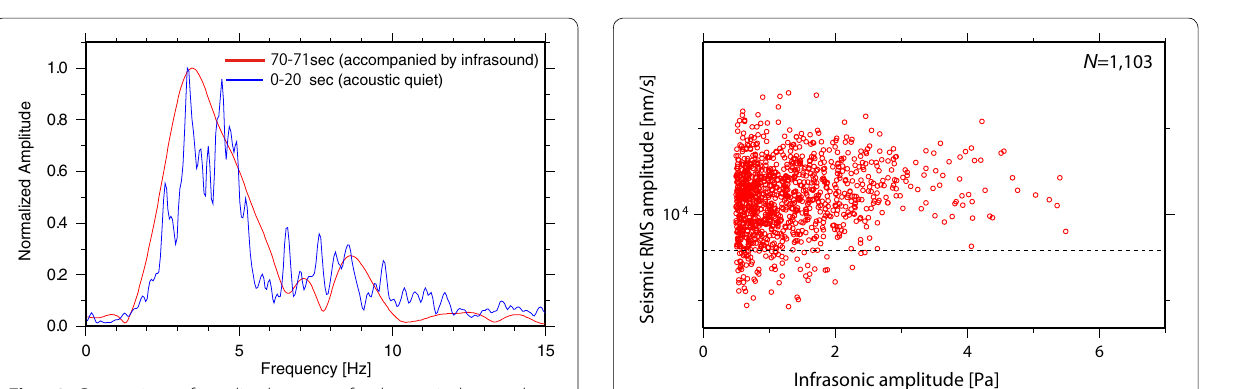
Fig. 13 Comparison of amplitude spectra for the vertical ground velocity waveforms at OWD station. The blue and red lines show the amplitude spectrogram of a seismogram during the acoustic quiet period (indicated by blue line in Fig. 11a) and immediately before the infrasonic onset (indicated by red line in Fig. 12)